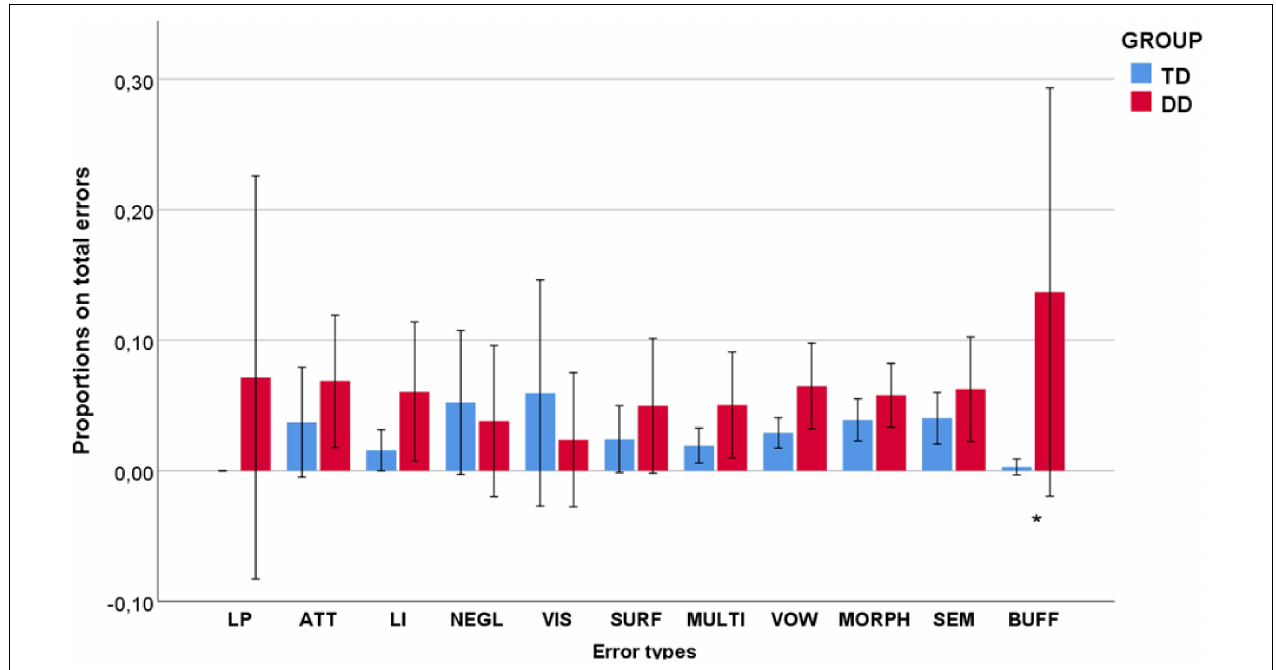
FIGURE 3 | Proportions of decoding errors by TD and DD children ( CI = 95%) (* p <